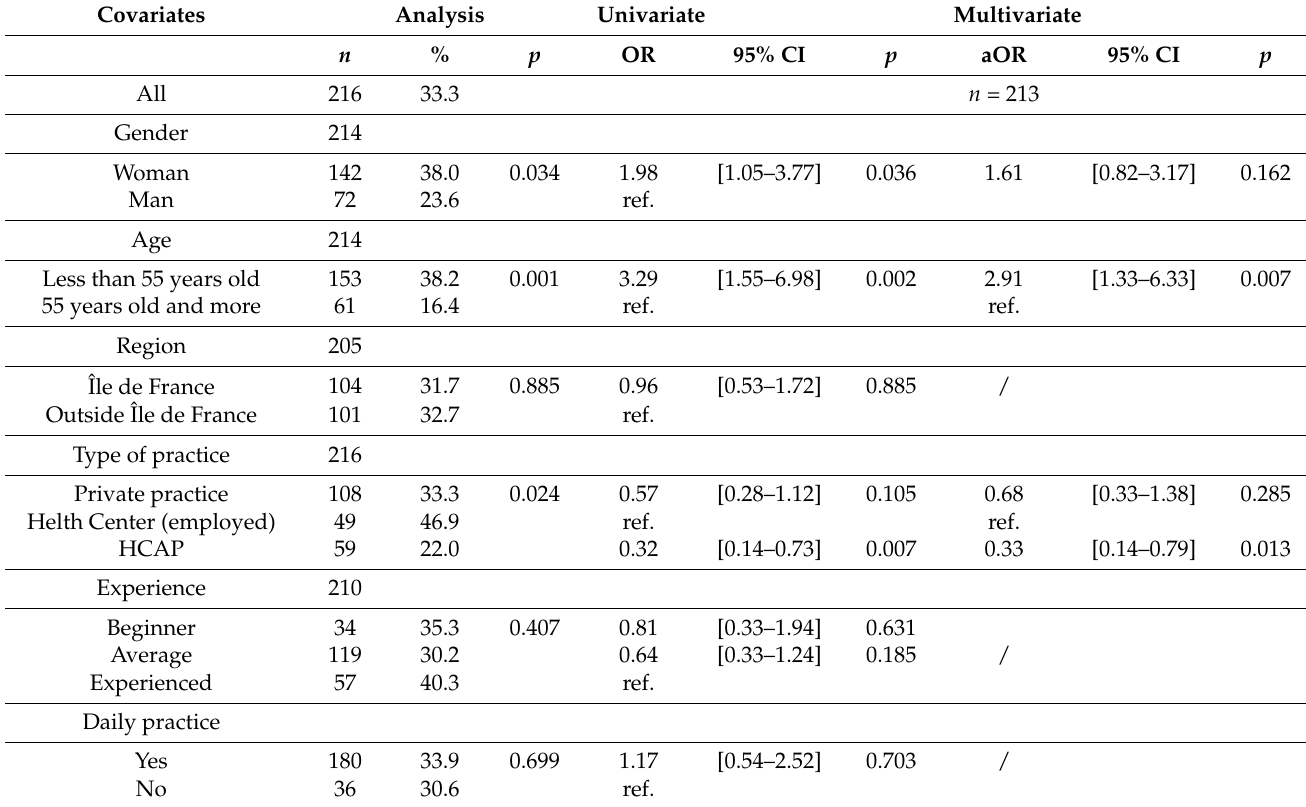
Table 2. Results of logistic regression models estimating the association between the use of serology prior to the immuniza- tion and general practitioner’s profile, among 219 general practitioners interviewed in France (2017–2018). Covariates Analysis Univariate